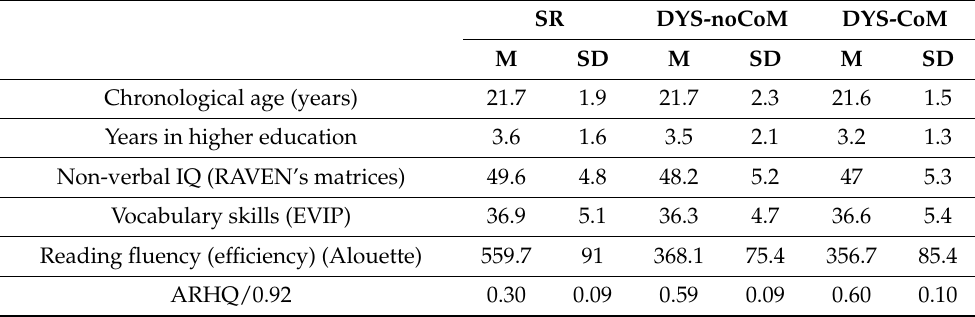
Table 1. Means (and standard deviations) for chronological age, educational level, vocabulary (raw scores), Raven’s matrices (raw scores), reading score, and Adult Reading History Questionnaire (ARHQ) scores for participants with dyslexia and without motor impairment, (DYS-noCoM) and with motor impairment (DYS-CoM) as well as for control skilled readers